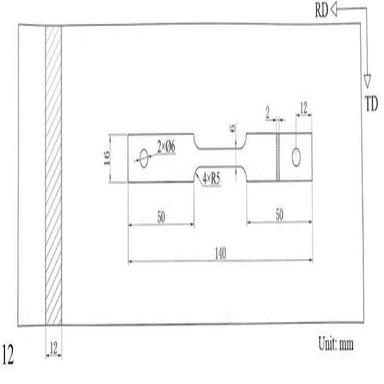
Dimension of tensile specimen.